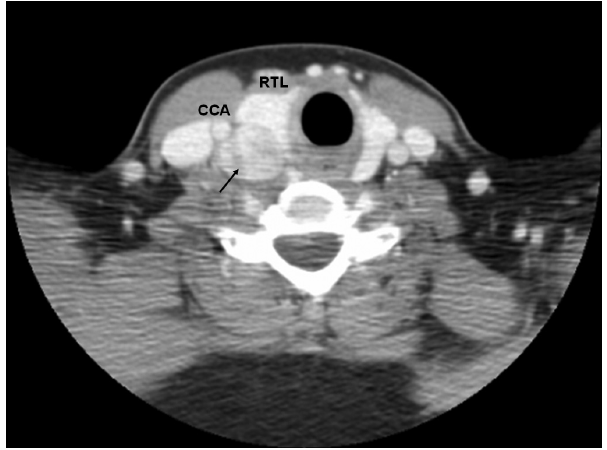
Figure 3 - Surgical specimen after resection